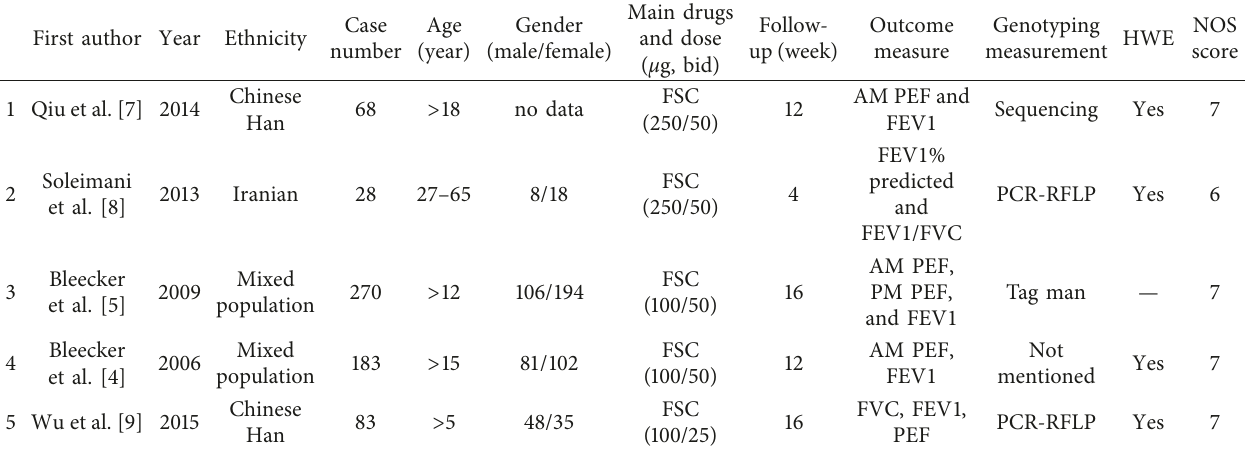
Table 1: Characteristics and methodological quality of included studies.